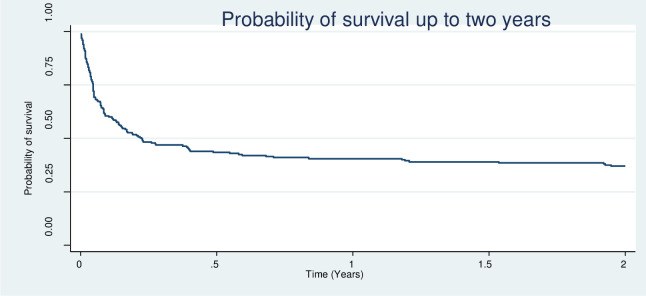
Kaplan-Meier plot showing survival of participants in the first 2 years of enrolment.